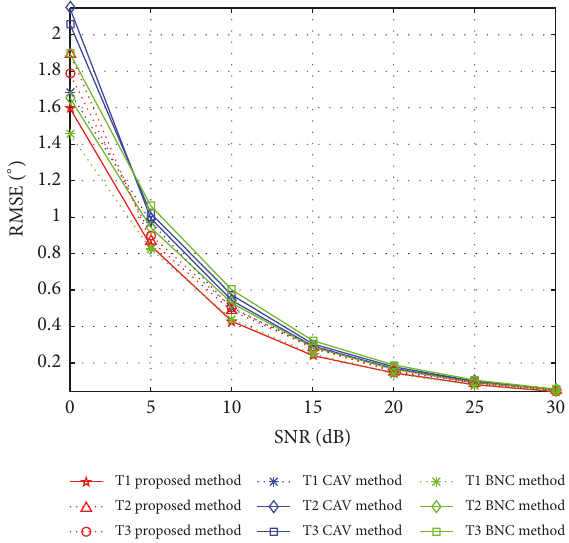
Figure 3: RMSE versus SNR with the snapshots being 200.